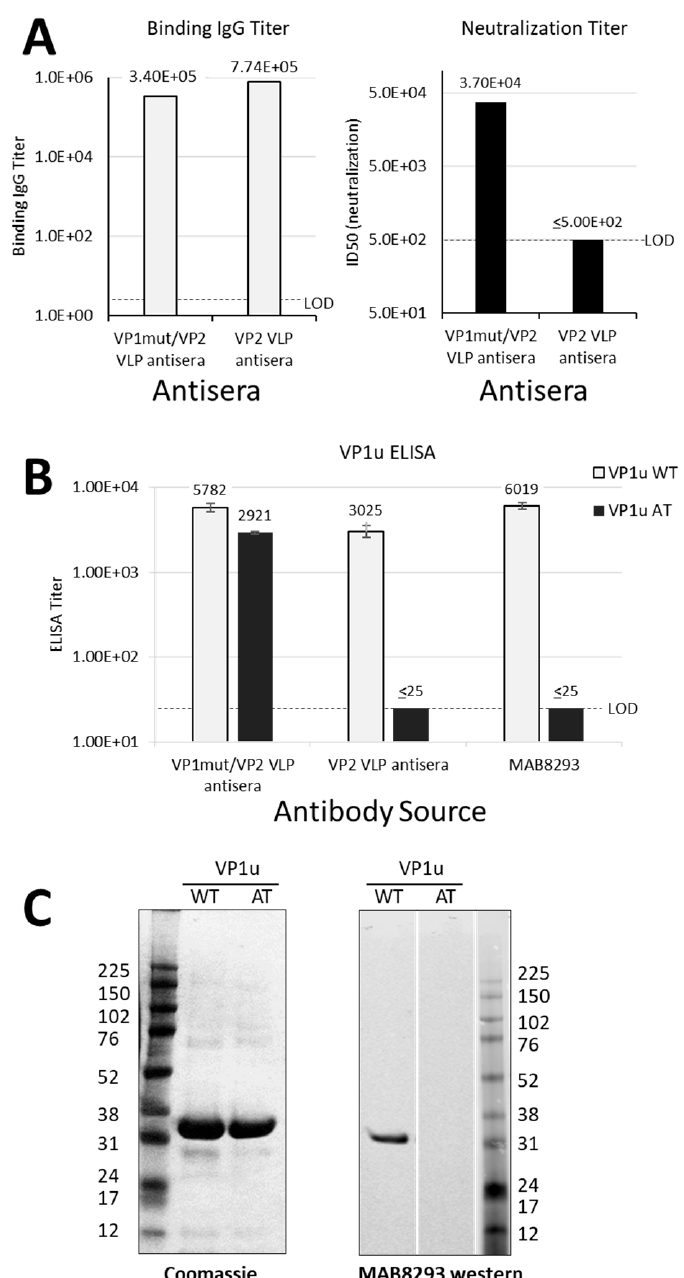
Figure 2. Differential antibody binding and function. ( A ) Results in A are graphed from data that were previously reported in table form by Chandramouli et.al. [8]. Pooled sera were from eight mice per group that were immunized either with VP1mut/VP2 VLP or VP2 VLP (see x-axes). These pooled sera were used in an ELISA with plates coated with VP1mut/VP2 VLPs (left). The lower limit of detection for this assay was determined using pre-immune sera (LOD, titer = 5). The same pooled sera were used in a neutralization assay with parvovirus B19 (right). The LOD of the neutralization assay was a titer of 500. ( B ) The same pooled mouse sera were newly tested in ELISAs with plates coated with peptides VP1uWT or VP1uAT (see legend). The monoclonal antibody mAb8293 was also tested. Means are shown with standard error bars. The LOD of these ELISAs was a titer of 25. ( C ) Purified VP1uWT and VP1uAT peptides were separated on SDS-PAGE and Coomassie-stained (left). Peptides were also tested by western blot, developed with monoclonal MAB8293